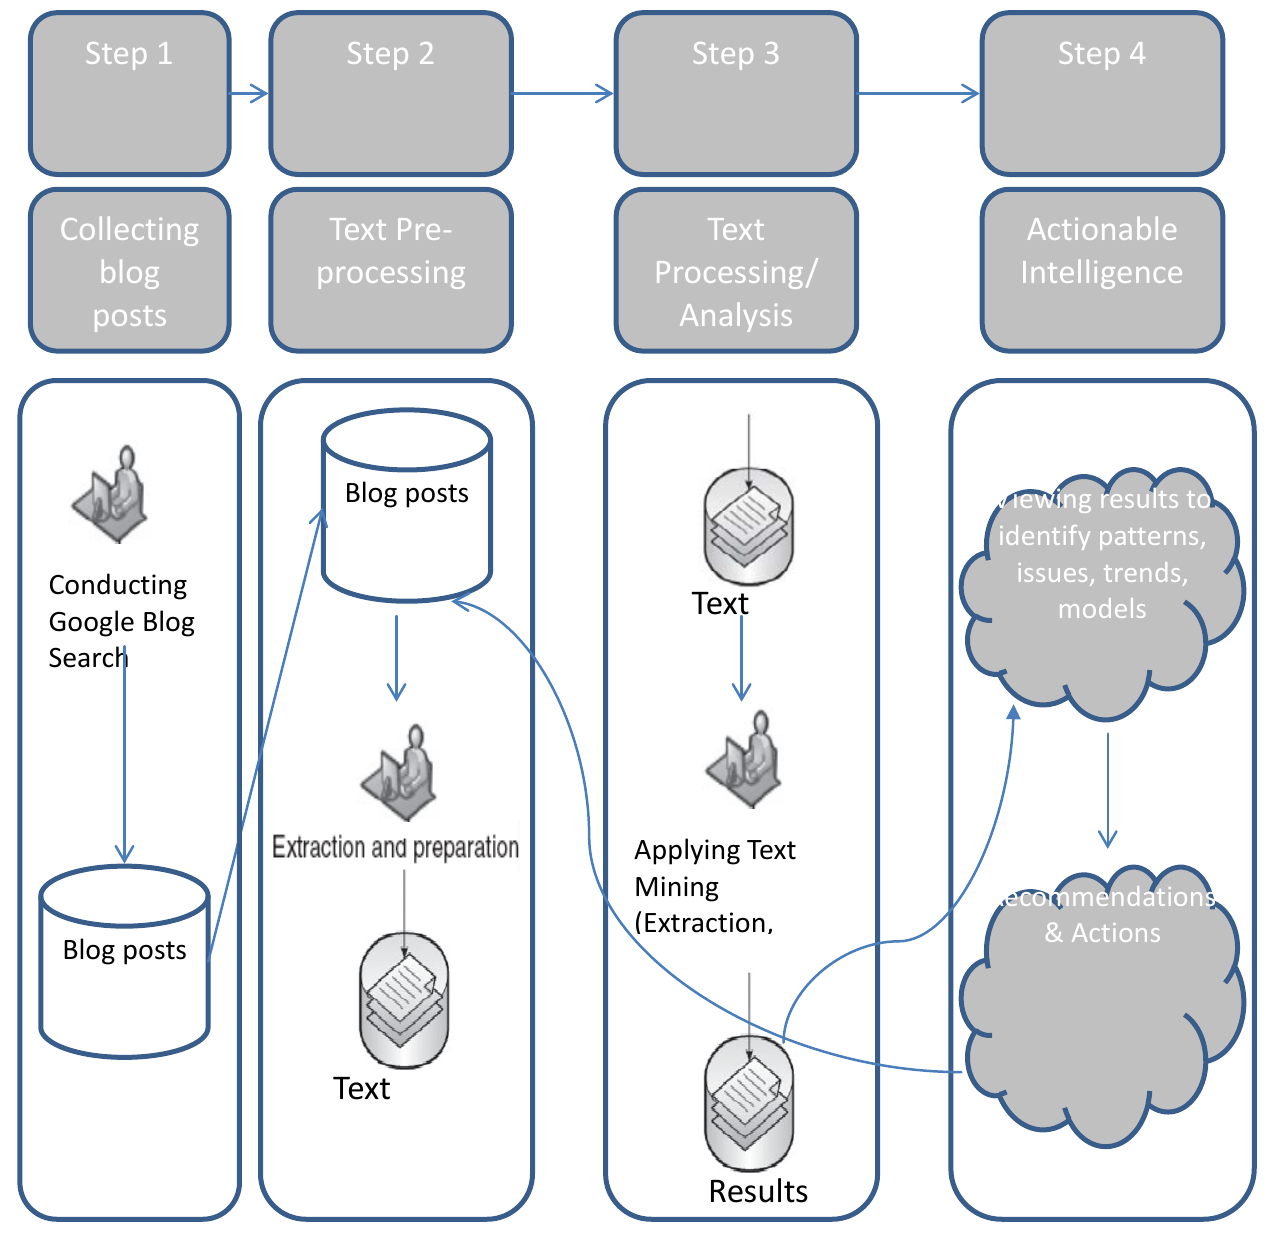
Figure 1 . Blog mining process (Source: Abdous & He,